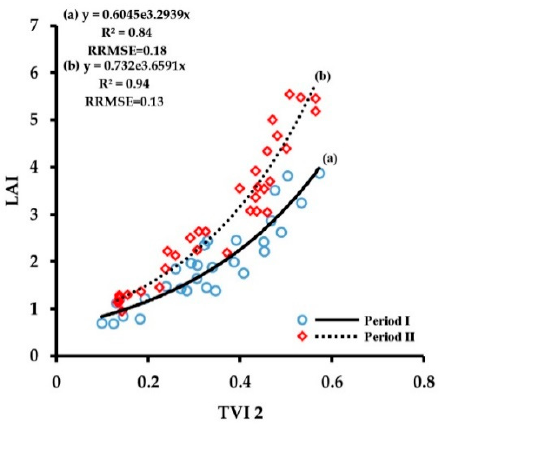
Figure 14. LAI ( A ), LDW ( B ), LNC ( C ) and LNA ( D ) of wheat at different growth